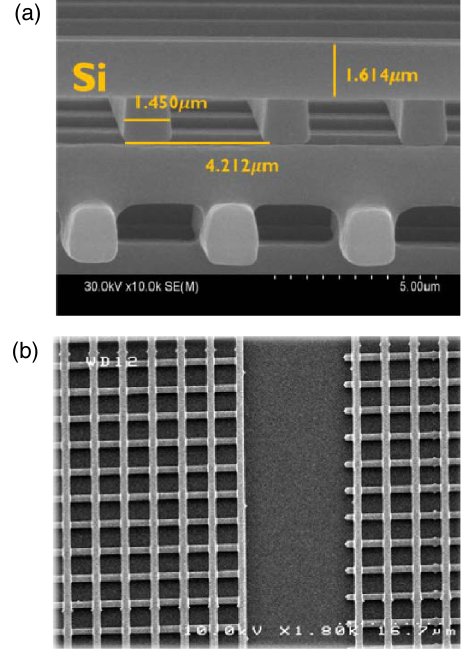
FIG. 12. (a) Side SEM view of an 18-layer silicon woodpile structure. (b) Top SEM view of the middle layers of a woodpile waveguide structure. Both are fabricated by the silicon membrane